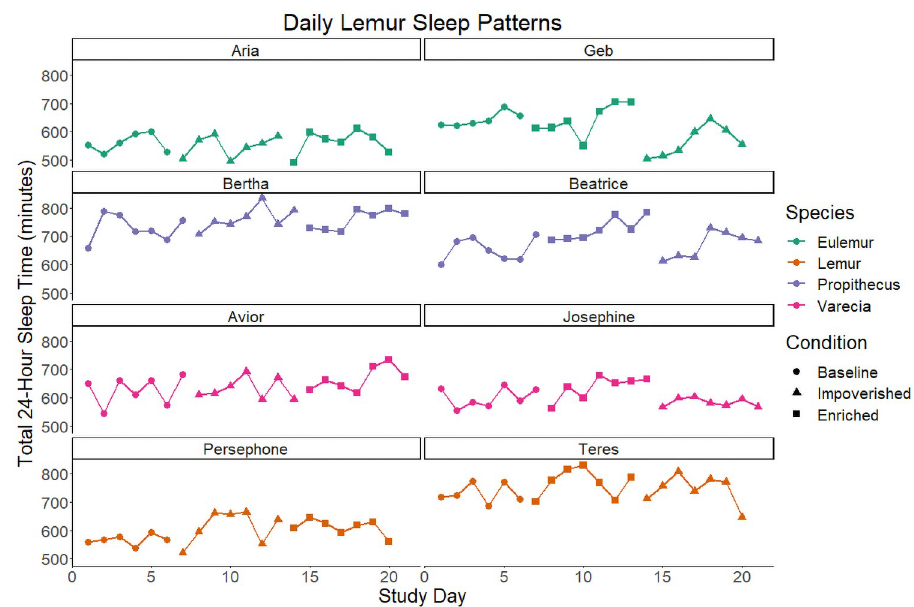
Fig 2. Daily lemur sleep patterns. Total sleep time in minutes for each observed 24-hour period, plotted by individual across days. Lemurs exposed to the impoverished condition first are presented on the left, those exposed to the enriched condition first on the right.